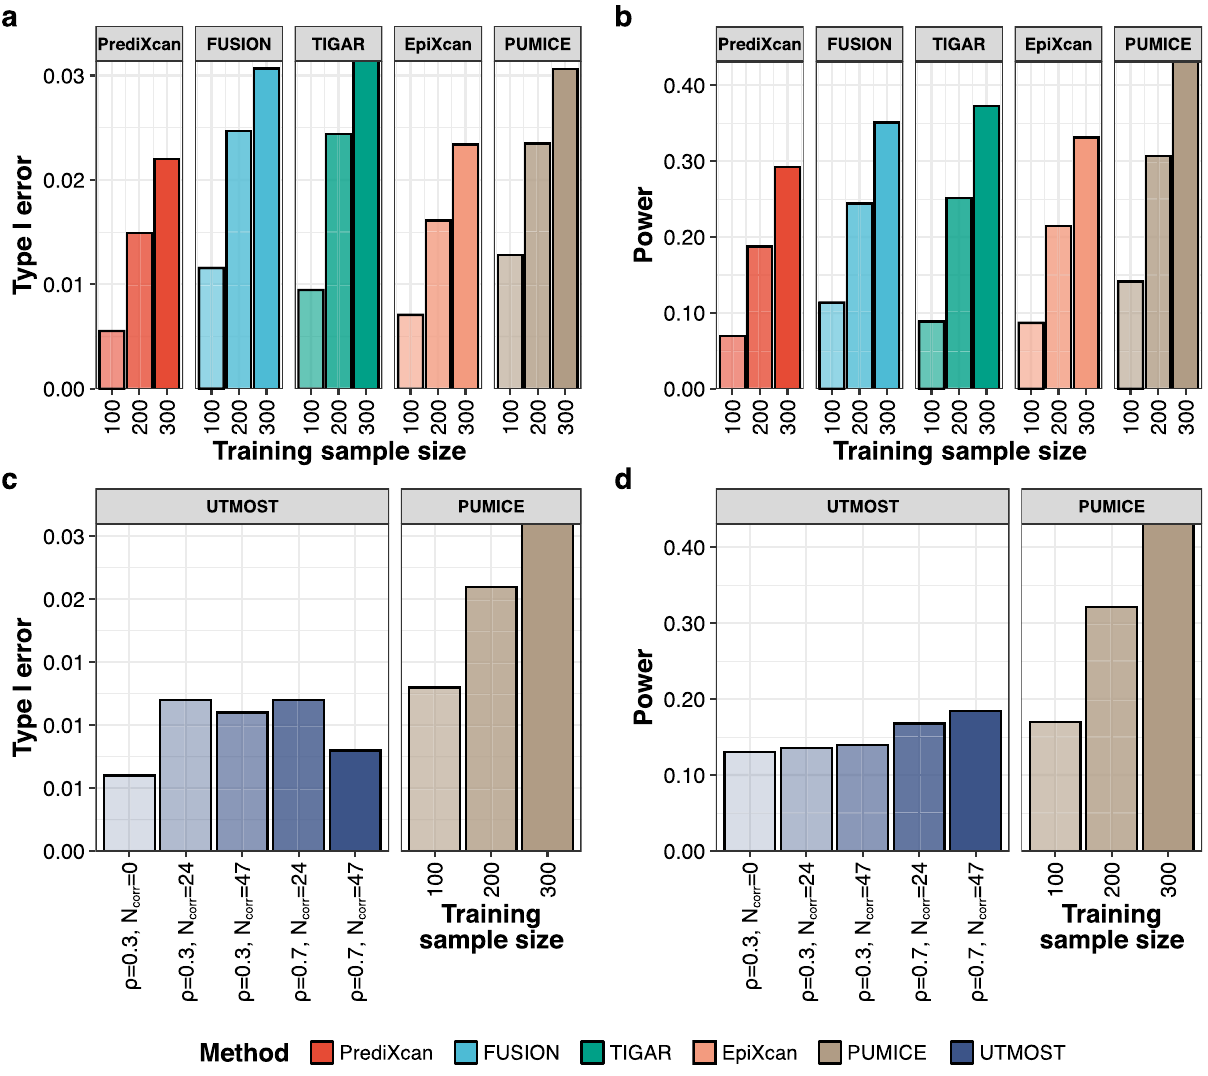
Fig. 1 Simulation studies comparing the performance of PUMICE to other TWAS methods. Panels ( a , b ) illustrates the comparison of PUMICE to other single-tissue TWAS methods for type I error ( a ) and power ( b ). Panels ( c , d ) illustrates the comparison of PUMICE to multi-tissue TWAS method (UTMOST) for type I error ( c ) and power ( d ). For UTMOST, we evaluate its performance across different combinations of genetic correlation between causal and correlated tissues ( ρ ) and number of correlated tissues (N corr ). Shadings represent different training sample sizes used to train gene expression prediction models for single-tissue TWAS methods and ρ /N corr combinations for multi-tissue TWAS